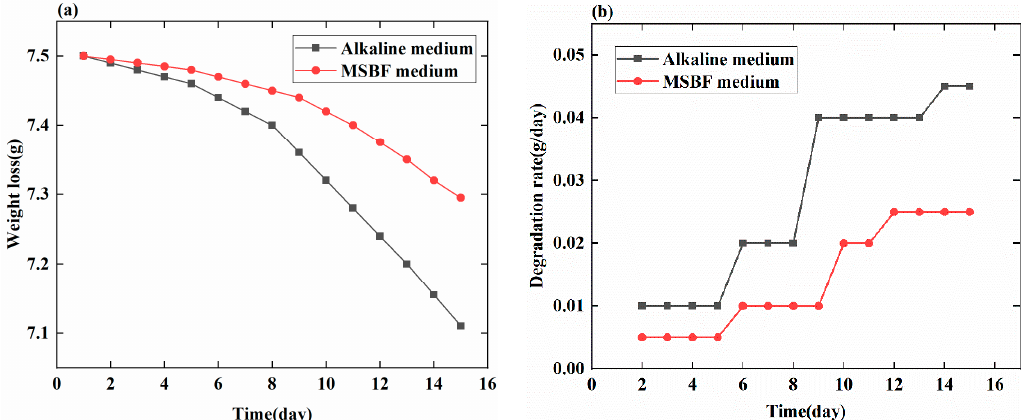
Figure 7. Weight loss (g) and degradation rate (g/day) of MBAB with increasing degradation time in alkaline medium and MSBF medium. ( a ) Weight loss of EMBAB in the alkaline and MSBF medium over 15 days. ( b ) Degradation rate of EMBAB in the alkaline and MSBF medium over 15 days .